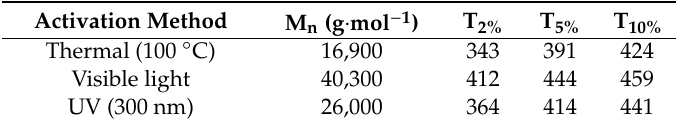
Table 2. Temperatures of decomposition (in air) of PVDFs synthesized with [Mn(CF 3 )(CO) 5 ] after a 24 h-reaction (2%, 5%, and 10% wt. loss).